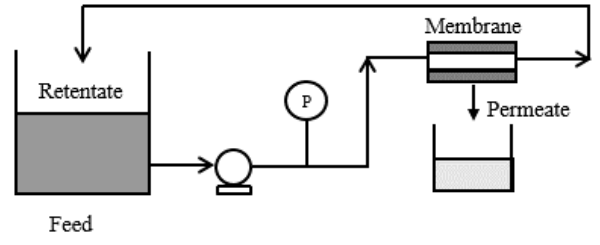
Figure 1. Cross-flow filtration testing unit.